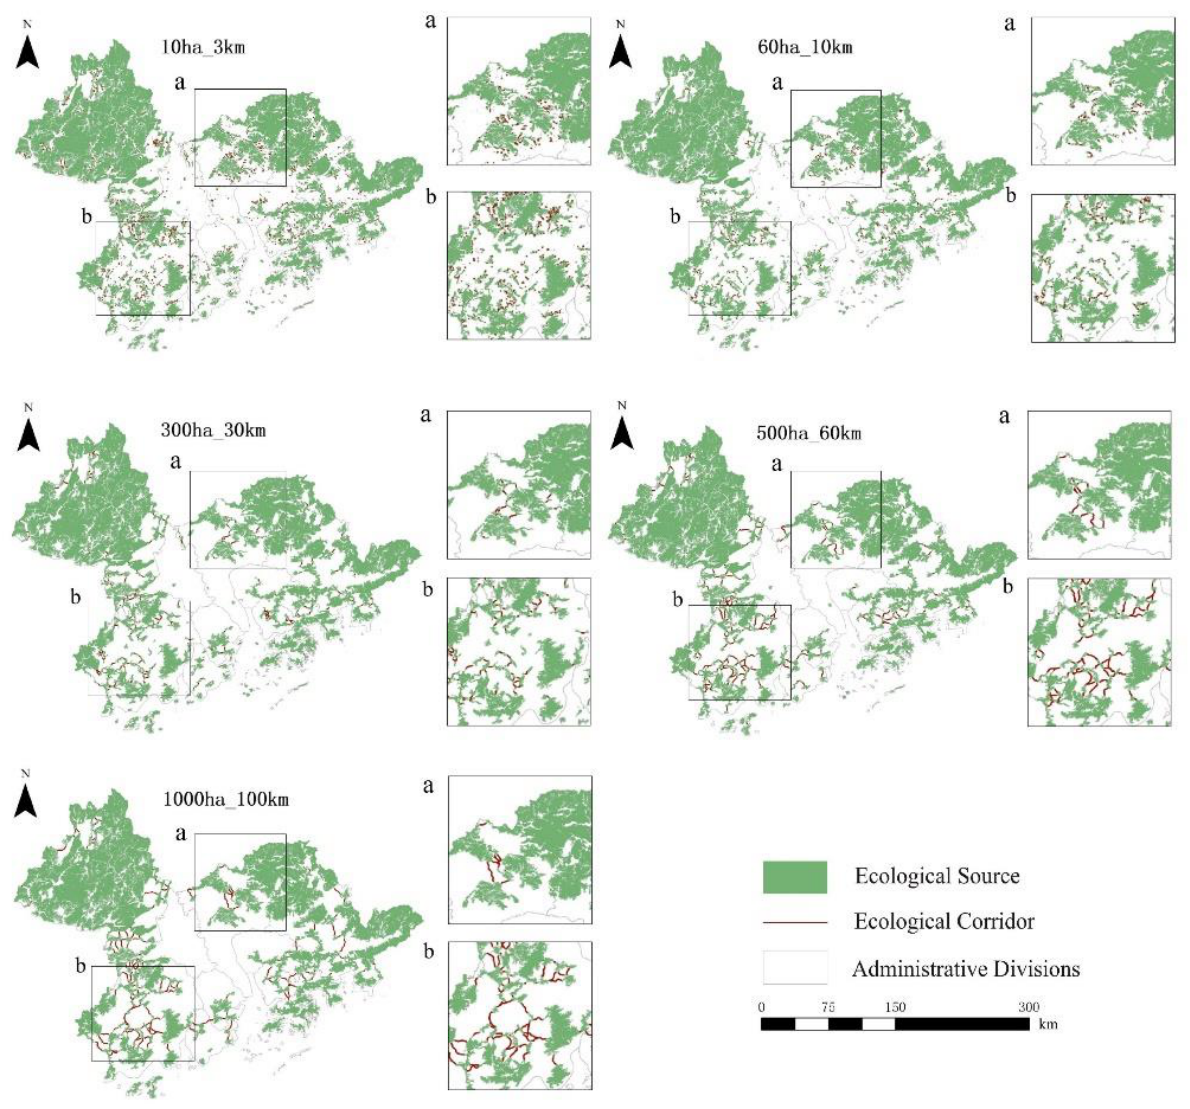
Figure 6. Five Scattered Scale Ecological Networks in the Guangdong – Hong Kong – Macao Greater Bay Area in 1990.